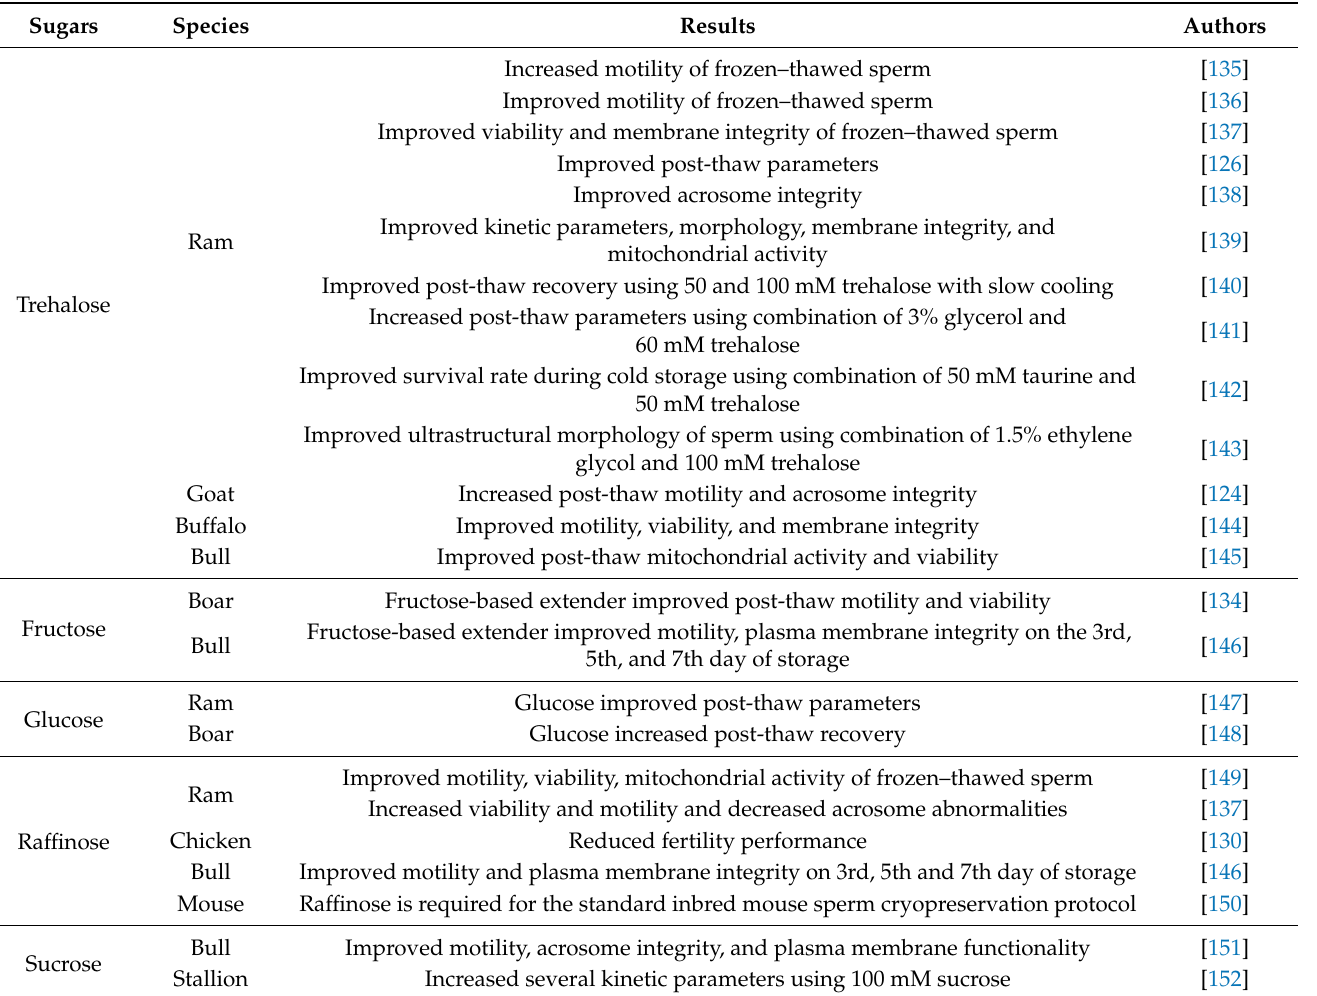
Table 2. Example literature for several sugar additives used in animal semen